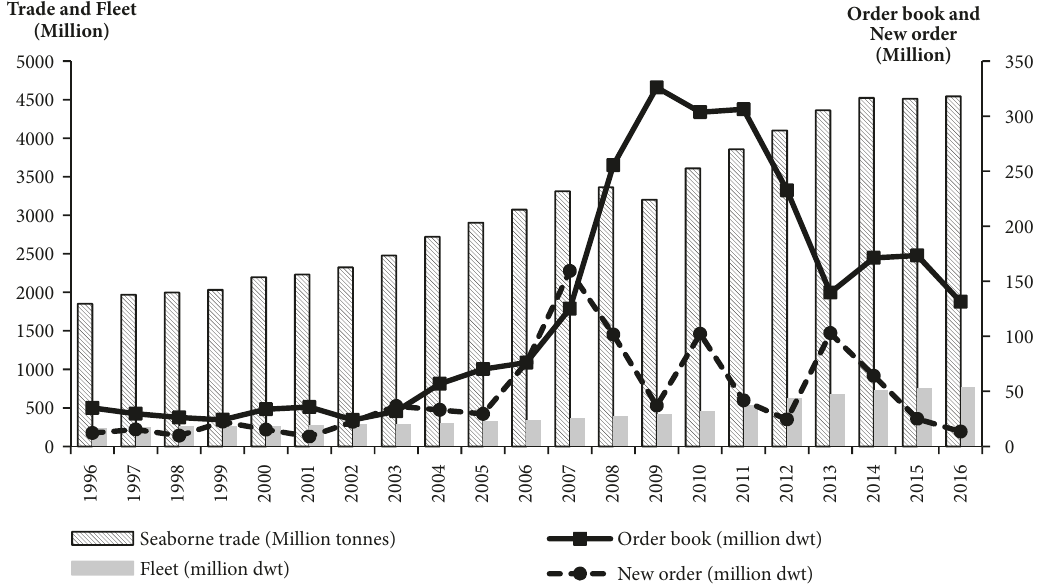
Figure 4: New order , order book , seaborne trade, and fleet development in the bulker